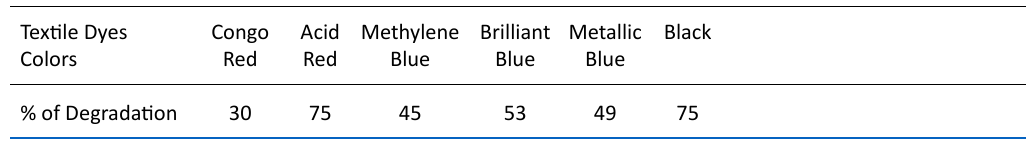
Table 10. Percentage of Dye Degradation